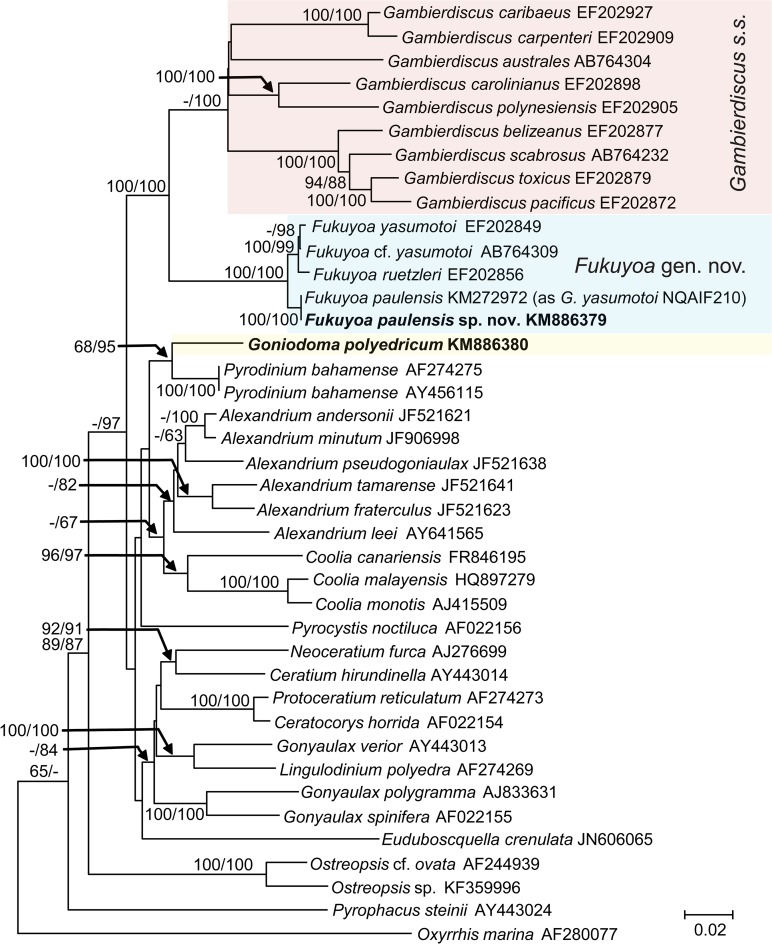
SSU rDNA-based phylogeny of Fukuyoa paulensis gen. et sp. nov. and Goniodoma polyedricum with some gonyaulacoid dinoflagellates.Sequences obtained in this study are bold-typed. Support of nodes is based on bootstrap values of ML/NJ with 1000 and 500 resamplings, respectively. Only values greater than 60 are shown. Oxyrrhis marina was used as outgroup.